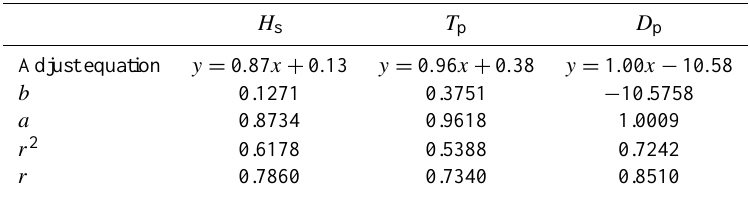
Table 1. Model and buoy data statistics.